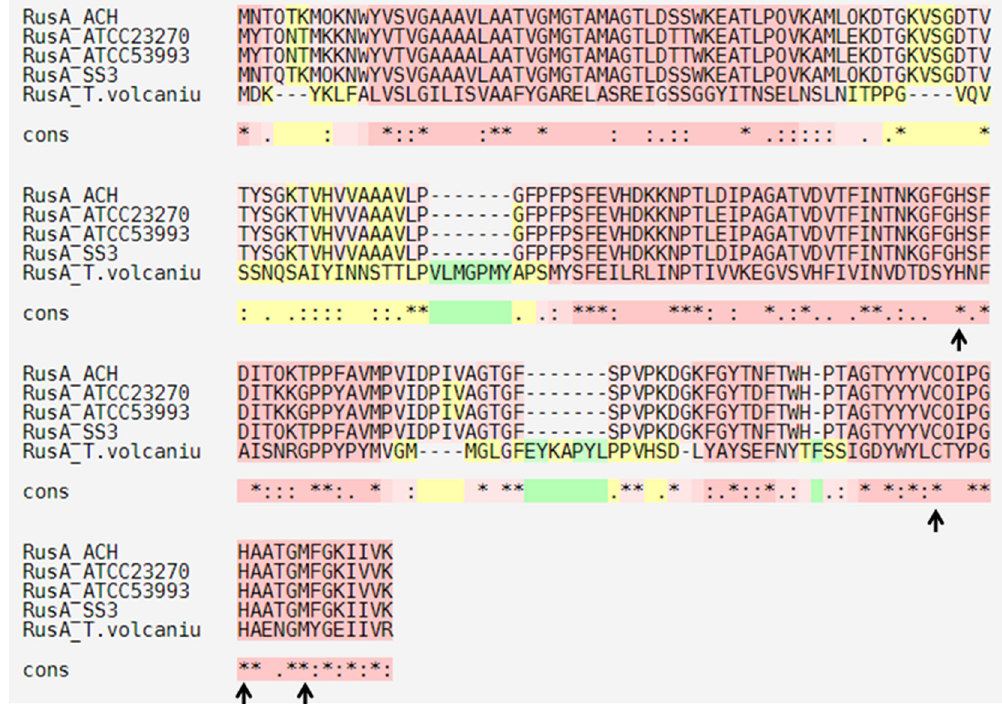
Figure 5. Amino acid sequence alignments of RusA proteins identified in different copper-resistant microorganisms. Black arrows indicate the conserved H-C-H-M motif that is part of the type I copper-binding of cupredoxin proteins. ATCC_23270: A. ferrooxidans ATCC 23270; ATCC_53993: A. ferrooxidans 53993; AFV_SS3: A. ferrivorans SS3; AFV_ACH: A. ferrivorans ACH; and T. volcaniu: Thermoplasma volcanium .